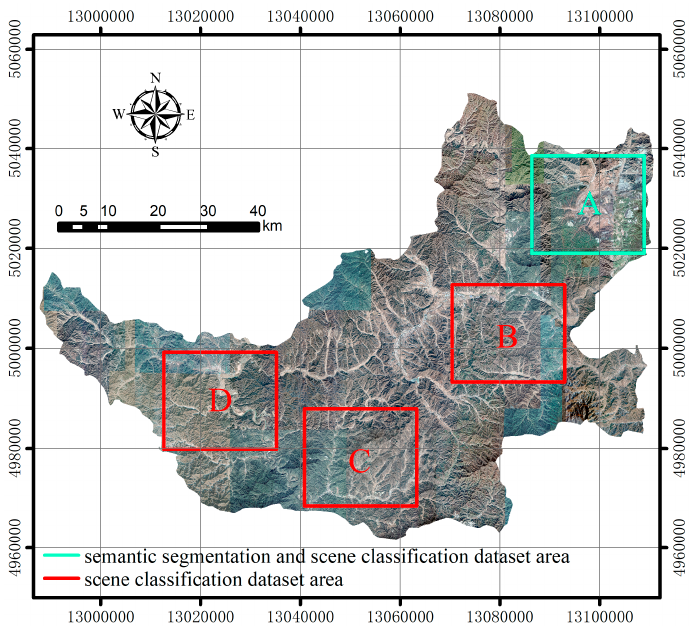
Figure 7. Spatial distribution of the datasets.